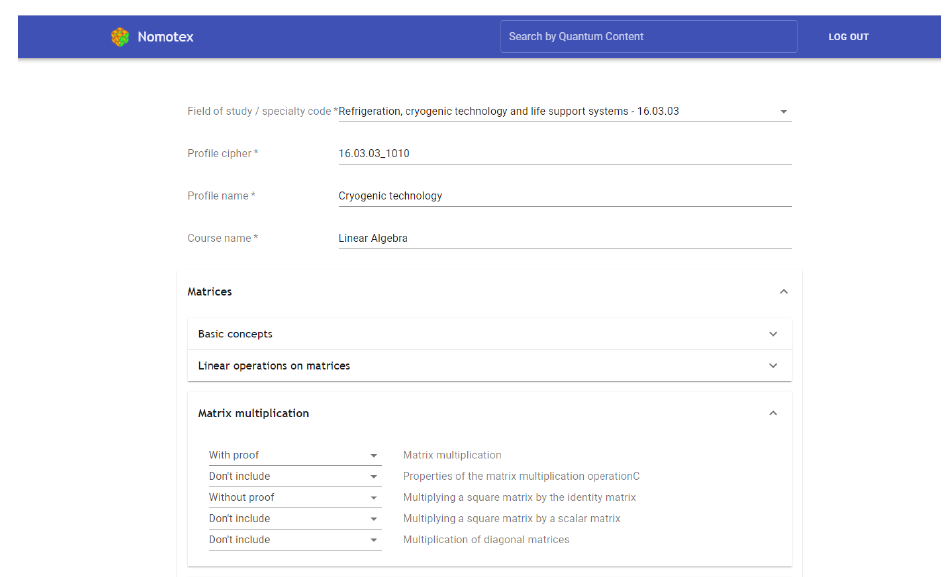
Fig. 4. Window of the subsystem "Designing neural network EP" DLS NOMOTEX.